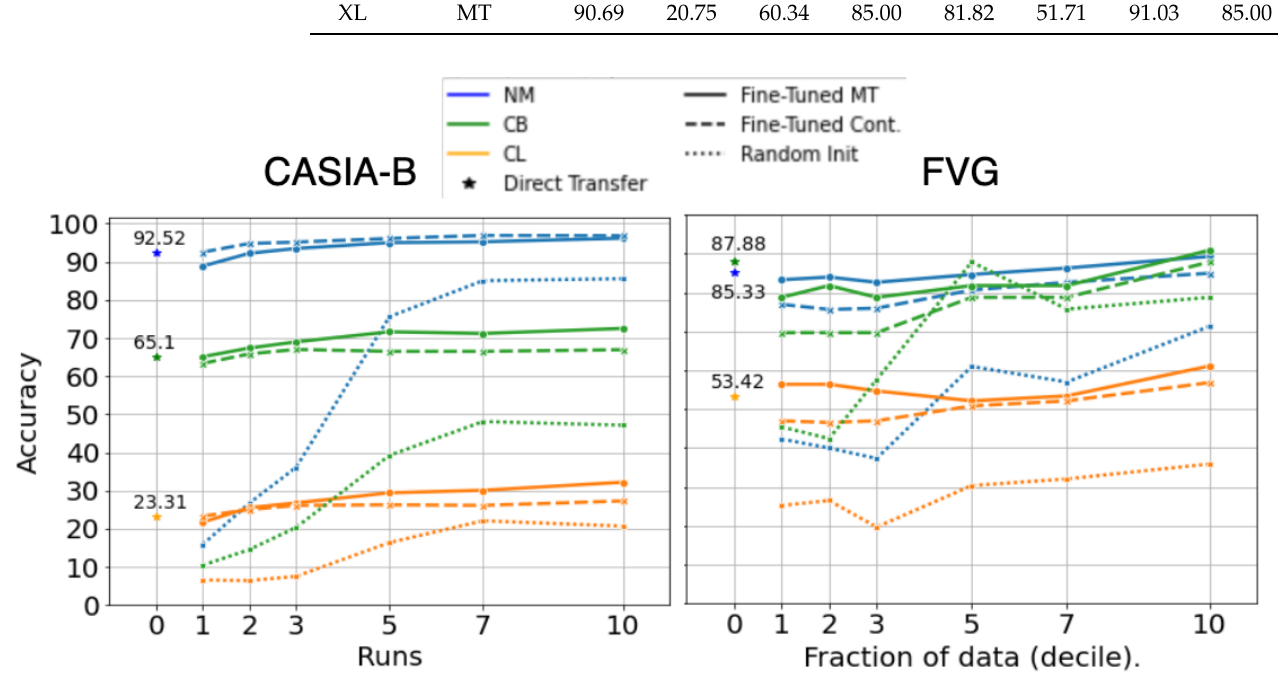
Figure 6. Fine-tuning results on gait recognition on CASIA-B and FVG, on progressively larger number of runs per identity. Compared to the same network randomly initialized, pretraining on DenseGait offers substantial improvements, even in the direct transfer regime. A consistent performance increase is obtained when also estimating